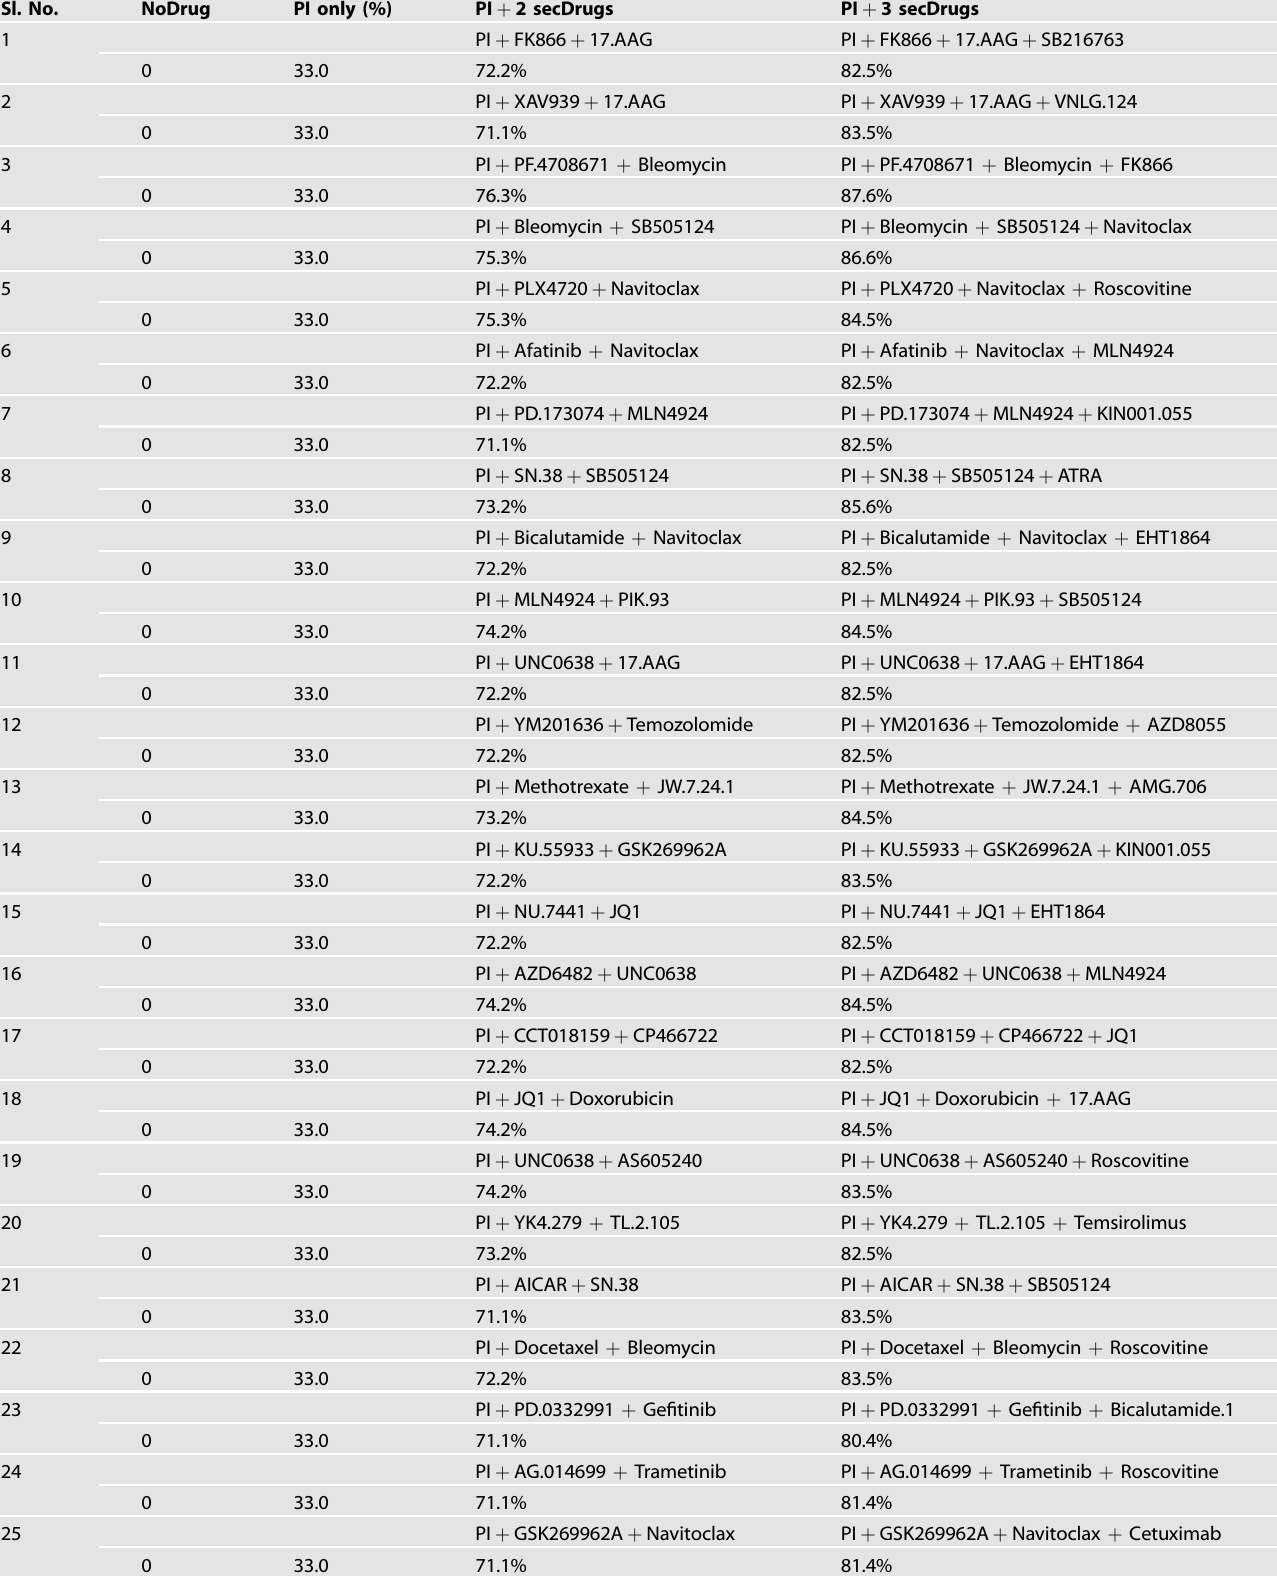
Table 1. Detailed list of top combination treatment regimens with a proteasome inhibitor (PI) backbone predicted using the secDrug computational